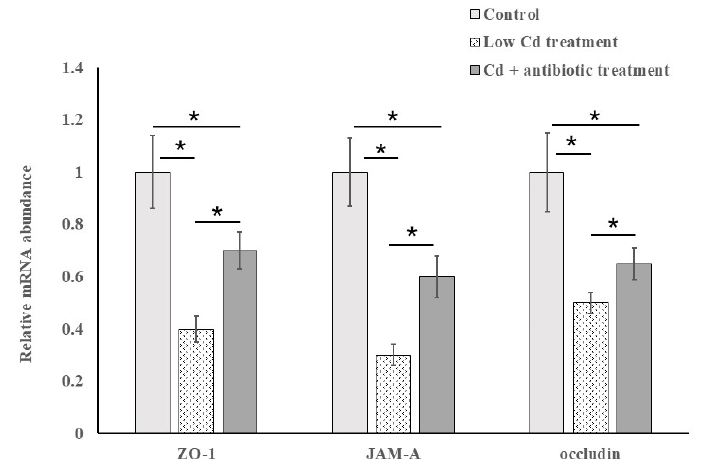
Figure 6. Levels of mRNA expression of the tight junction proteins from the control and low Cd treatment groups. Results are expressed as mean values (fold change respect to control). * p < 0.05.